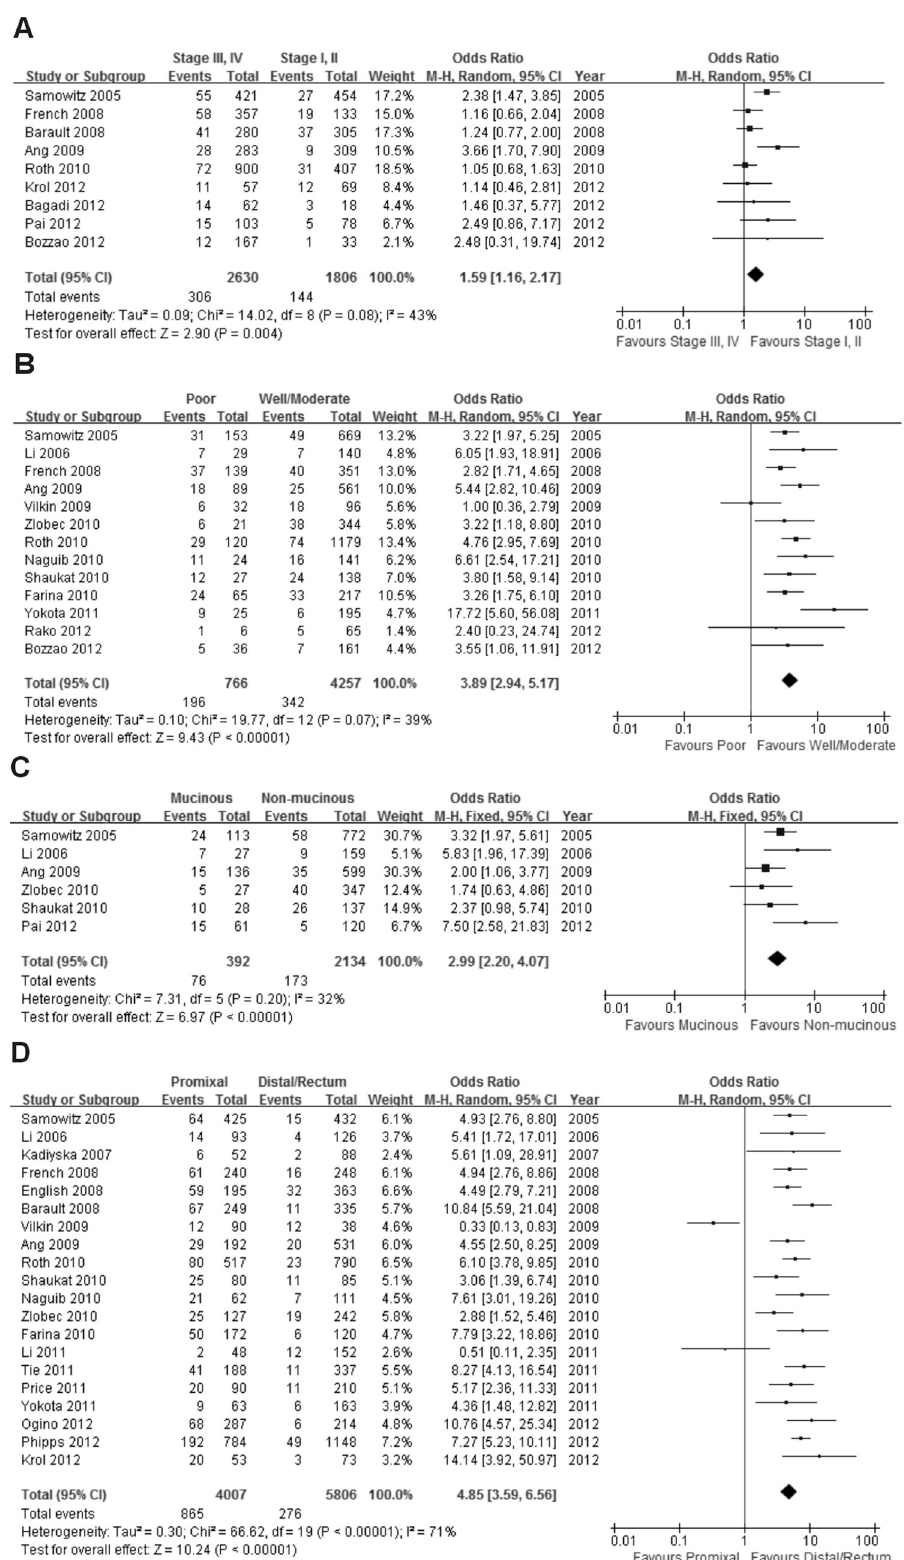
Figure 4. The association of BRAF V600E mutation with clinicopathological features. Random effects model of the odds ratios (ORs) with 95% confidence intervals (CIs) of the association of BRAF V600E mutation with clinical stage (A), tumor differentiation (B) and tumor location (D). Fixed effects model of the odds ratios (ORs) with 95% confidence intervals (CIs) of the association of BRAF V600E mutation with mucinous histology (C).